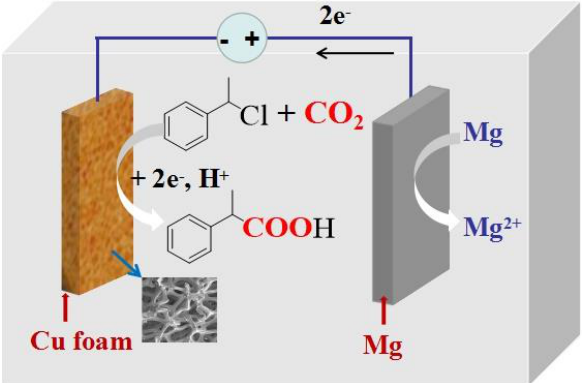
Figure 1. Electrocatalytic carboxylation of 1-phenylethyl chloride at Cu foam.